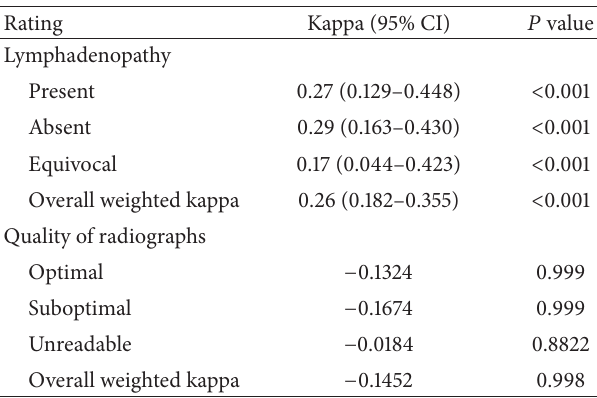
Table 2: Overall agreement amongst all raters on lymphadenopathy and quality of